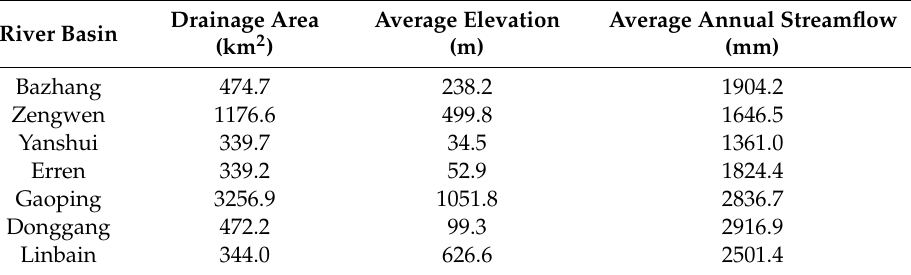
Figure 1. Location of seven river basins in southern Taiwan. Table 1. Information of catchment